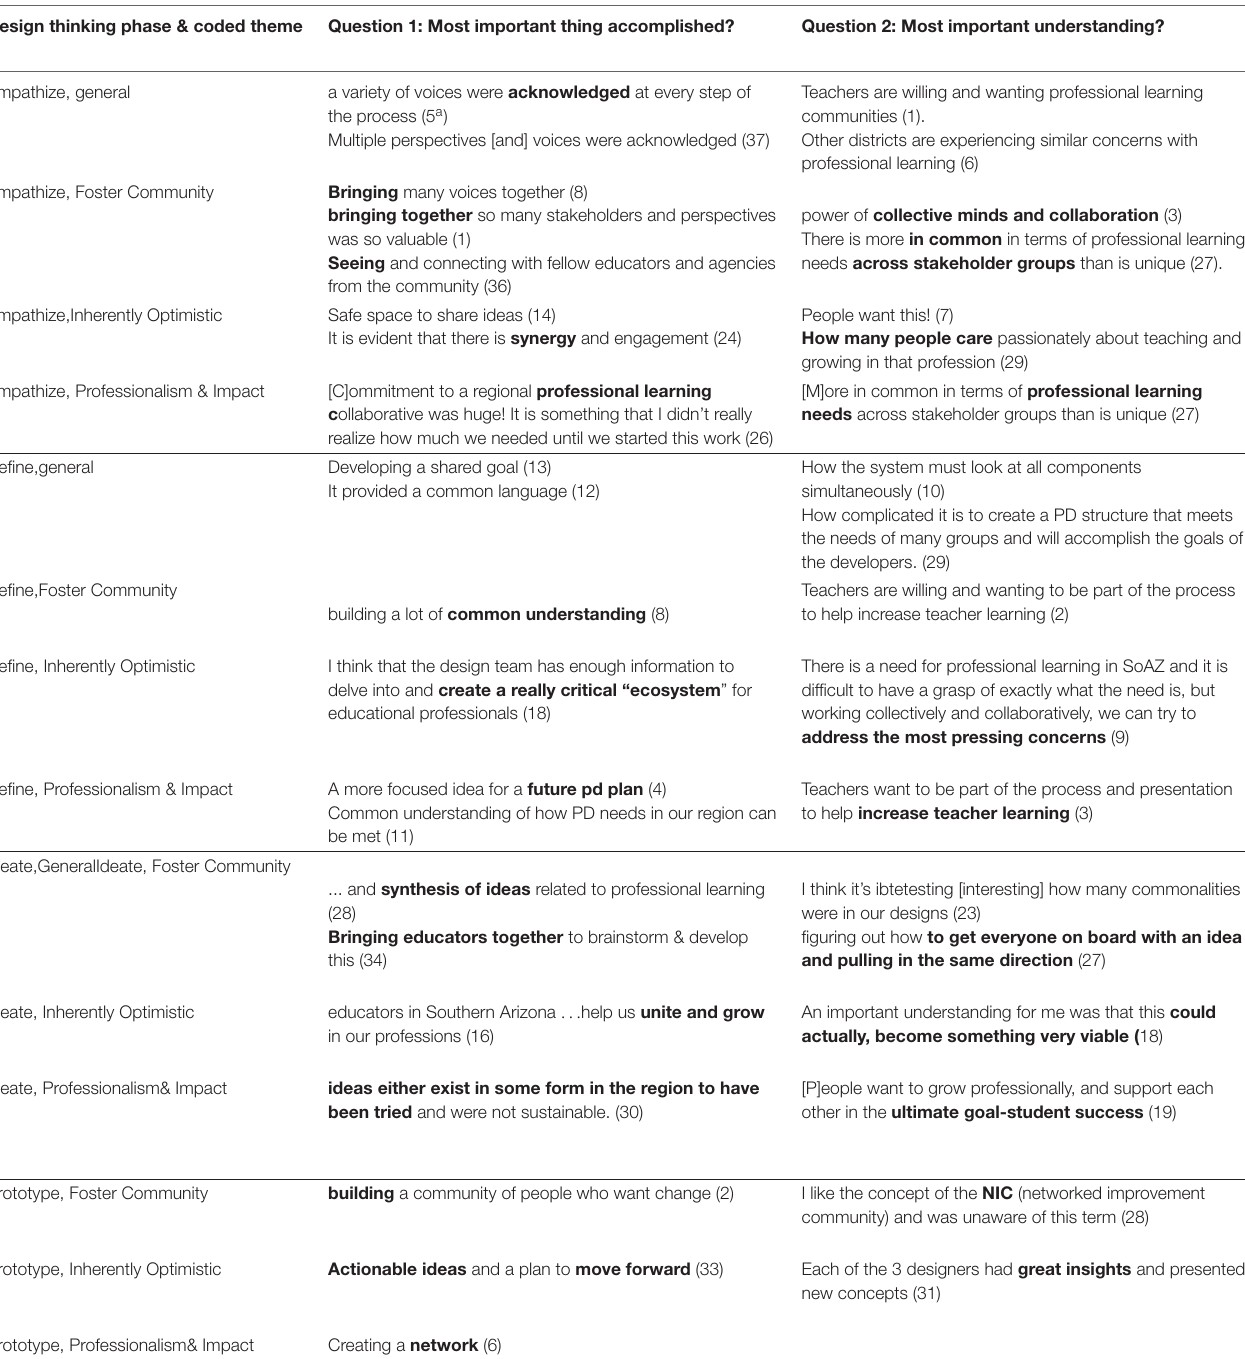
TABLE 2 | Examples of design thinking phases and themes from design charrette participants. Design thinking phase & coded